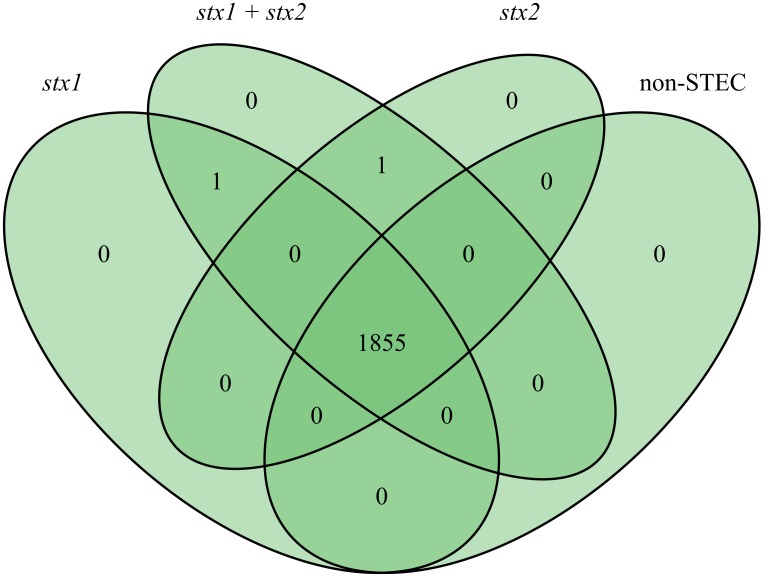
Venn diagram result at checkpoint 1 of bioinformatics pipeline A of 128 genomes grouped into stx1-positive STEC (25 genomes), stx1+stx2 positive STEC (27 genomes), stx2 positive STEC (43 genomes) and non-STEC (33 genomes).